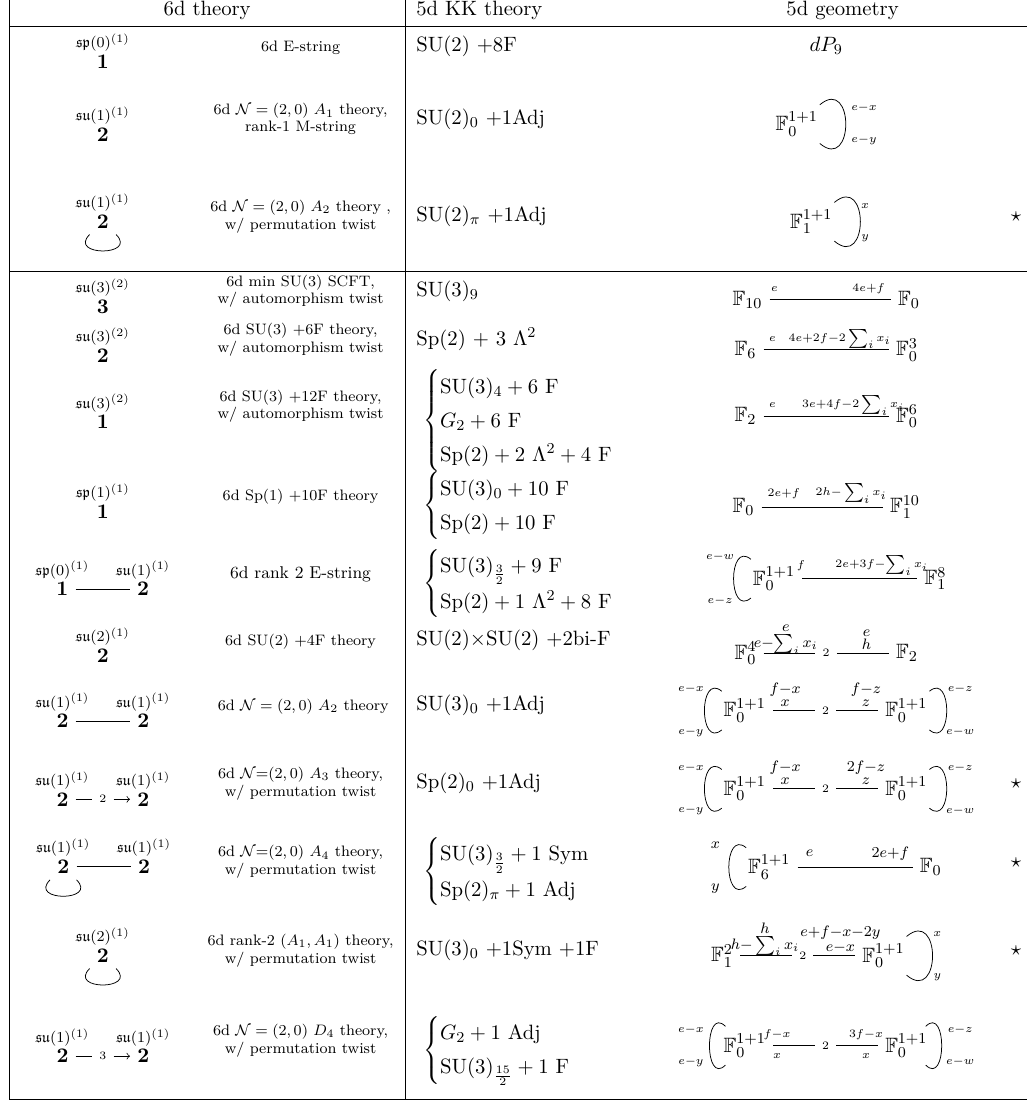
Table 1 . Rank 1 and rank 2 KK theories [16, 47, 61]. Theories labelled with ? are referred to as non-geometric , in the sense that these are not conventional geometric descriptions. These theories are understood as algebraic proposals that mimic many features of local threefolds, but may not satisfy the consistency conditions reviewed in section